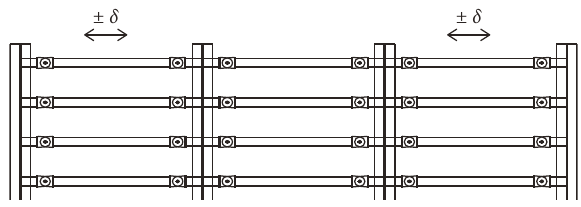
Figure 18: Traditional railing.